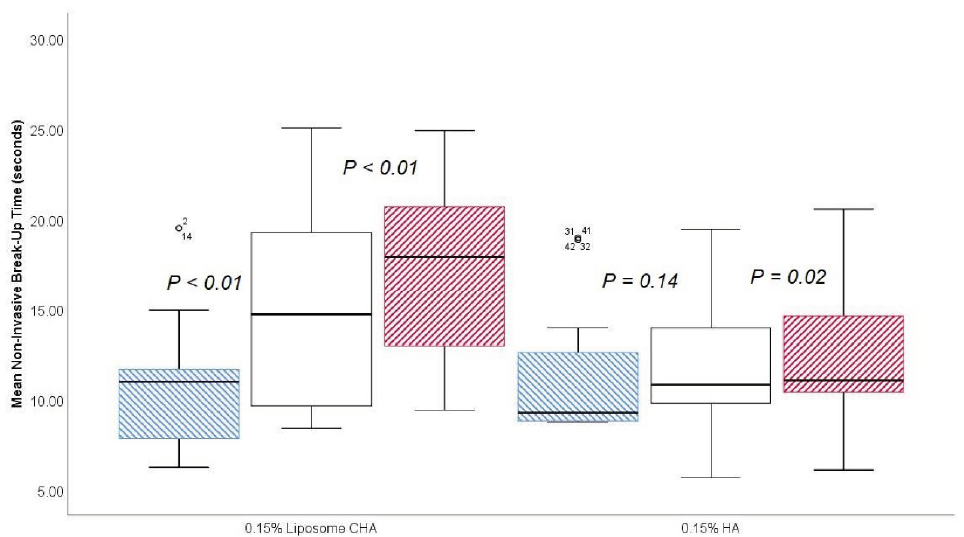
Figure 5. Box and plot of mean noninvasive break-up between previous (blue), 30 min (white), and 45 min (red) after eyedrop instillation.